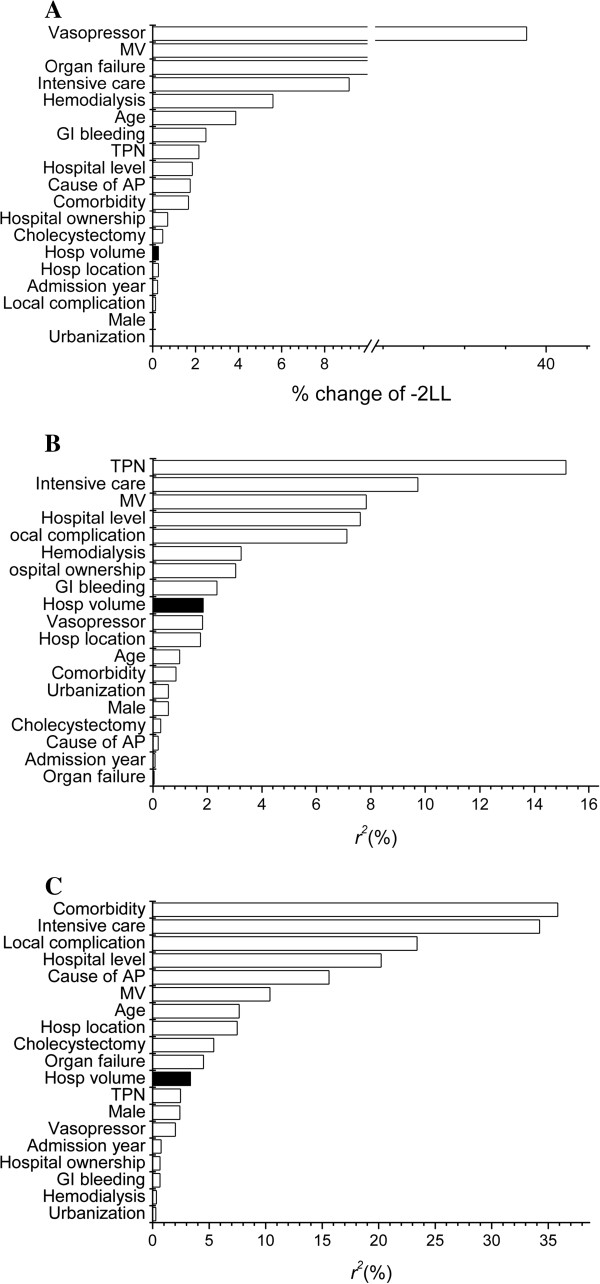
Variances of outcomes (A: hospital mortality, B: hospital length of stay, C: hospital charges) explained by various variables (MV: mechanical ventilation; TPN: total parenteral nutrition; AP: acute pancreatitis).